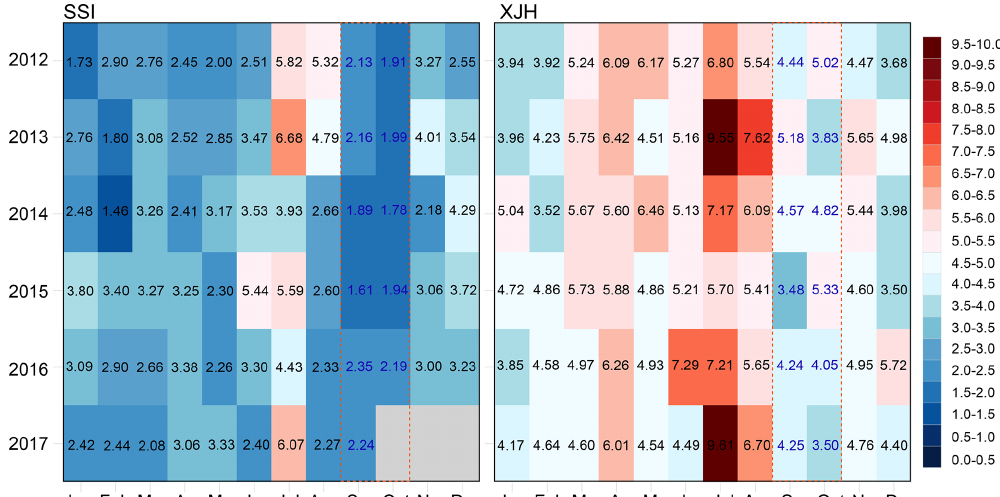
Figure 5. Calculated monthly mean ratios of daily maximum O 3 concentrations (O 3 − max ) to minimum O 3 concentrations (O 3 − min ) at the Sheshan Island (SSI, remote and oceanic) and Xujiahui (XJH, urban) sites, respectively, from 2012 to